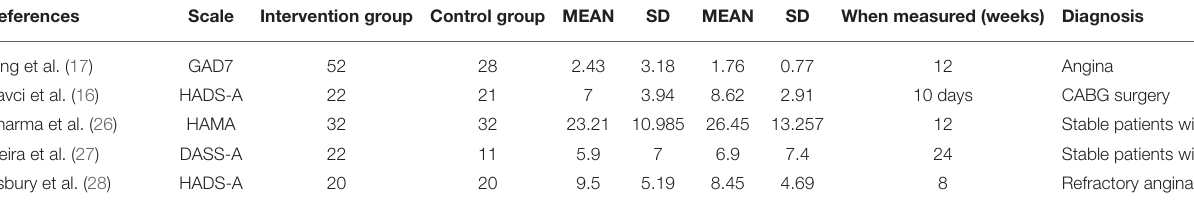
TABLE 3 | Baseline of anxiety included in the study.